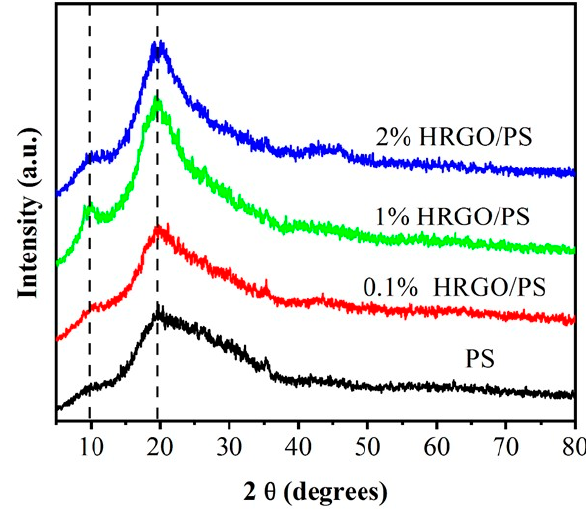
Figure 3. XRD patterns of 0.1% HRGO/PS, 1% HRGO/PS, and 2% HRGO/PS nanocomposites.